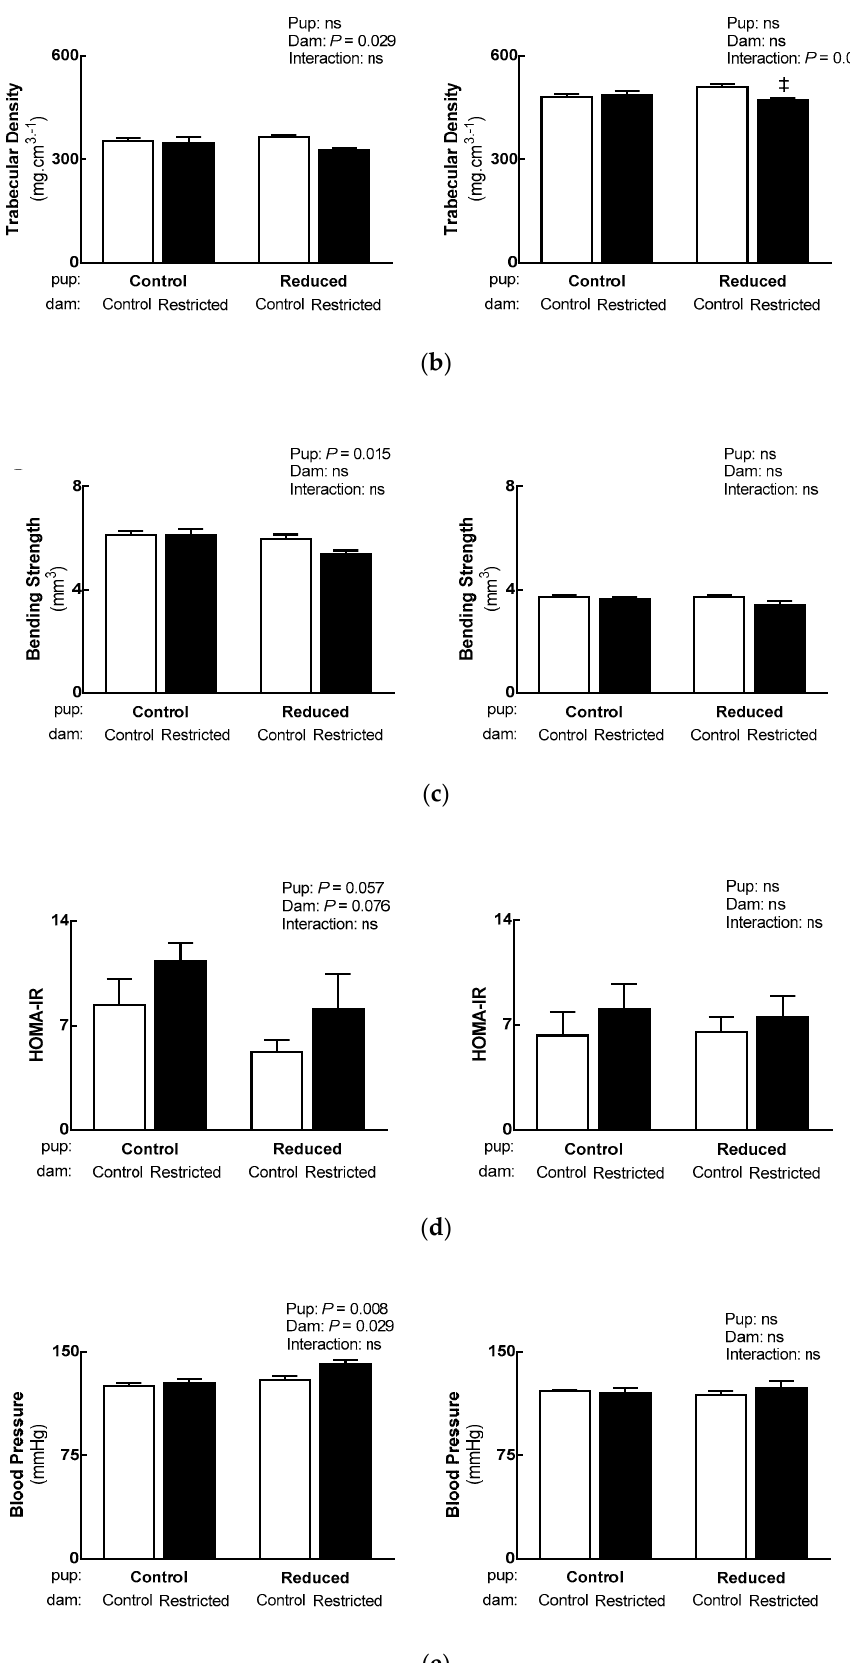
Figure 4. Effect reducing litter size has on adult offspring bone ( n = 9–19 per group, with n = 1 representing 1 male and female per litter) and cardiometabolic health ( n = 5–11 per group, with n =